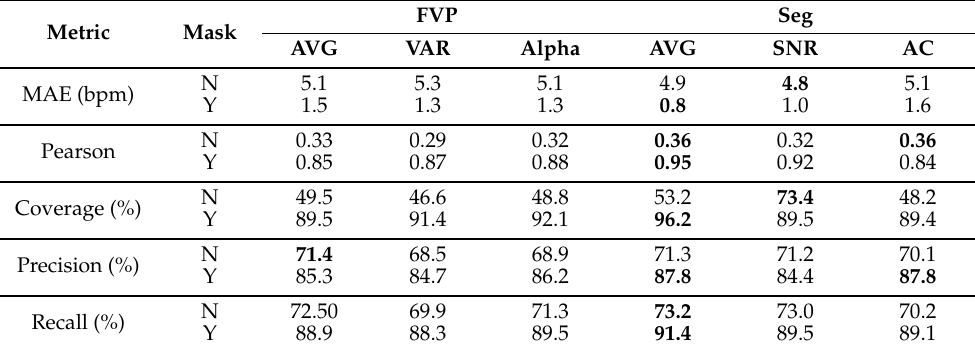
Table 1. Statistical results obtained by six benchmarked methods on Dataset A, using the default setting. Boldface character denotes the best result per row.